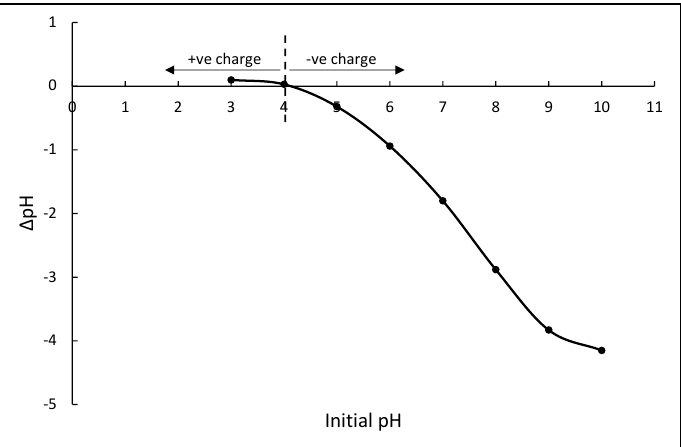
Figure 6. The zero − point charge of FMS/PU.